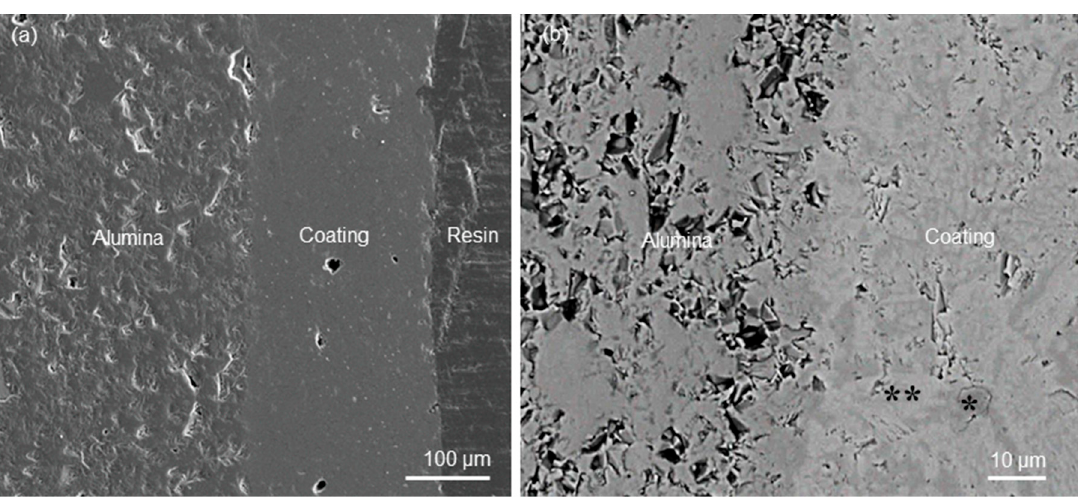
Table 1. Mechanical properties of the